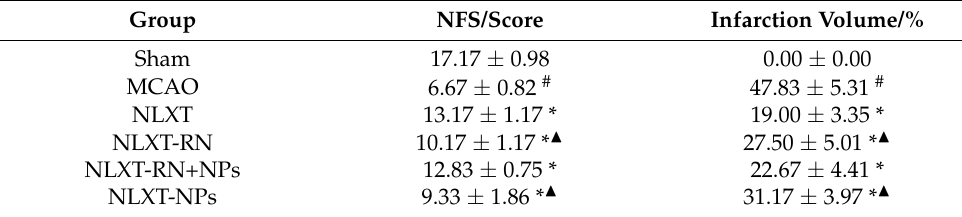
Table 1. Neurological scores and cerebral infarction volumes of rats (x ± s, n ≥